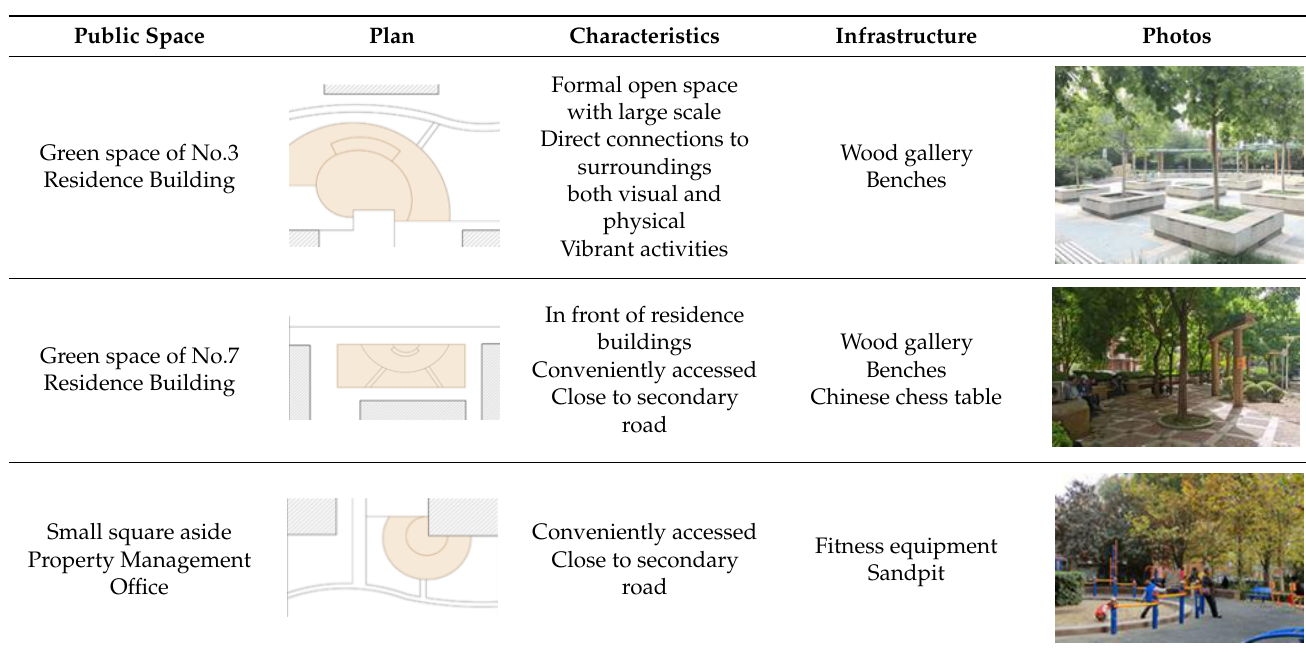
Table 3. Public space observation and mapping of Community Jianshebudayuan.